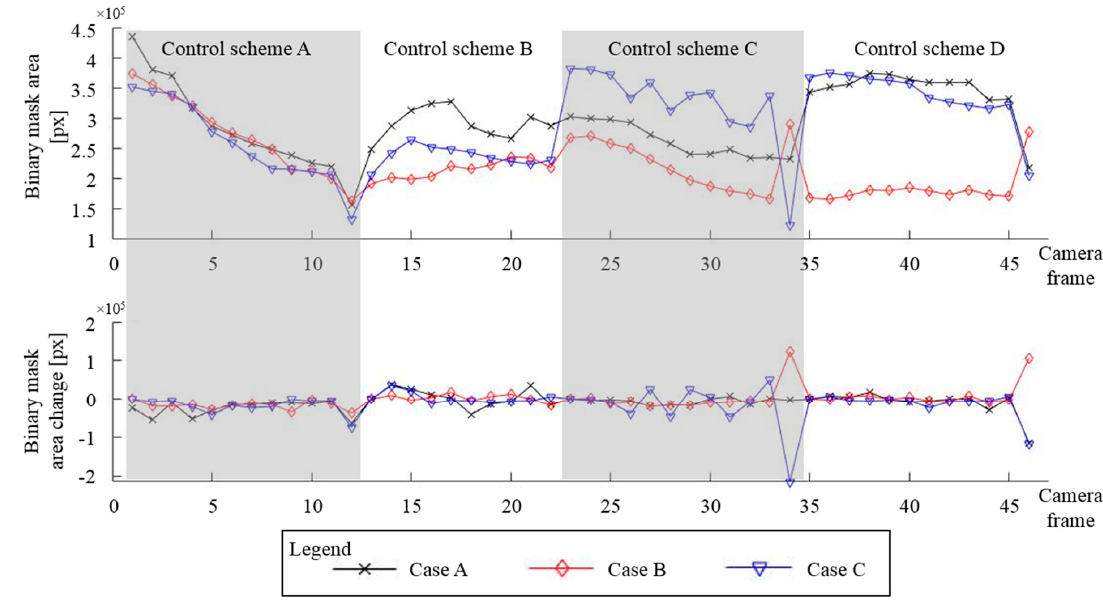
Figure 14. Binary masks trends (top) and their rate of change (bottom). The binary mask area is the sum of all mask pixels. The figure shows data points in the same order as the experiments were performed (middle focus, middle defocus, translate to 3rd, and translate to 4th column).